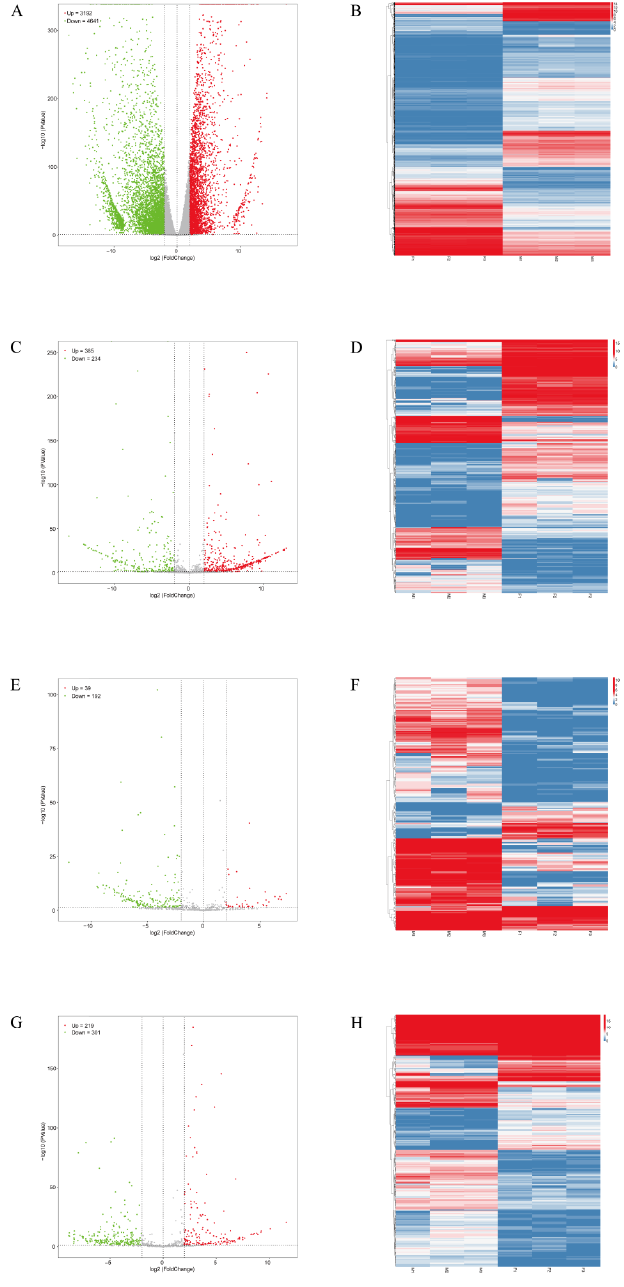
Figure 1. The volcano plots and heat maps of DE mRNAs and ncRNAs. ( A , C , E , G ) indicate the vol- cano plots of DE mRNAs, DE lncRNAs, DE circRNAs, and DE miRNAs, respectively. ( B , D , F , H ) show the heat maps of DE mRNAs, DE lncRNAs, DE circRNAs, and DE miRNAs,